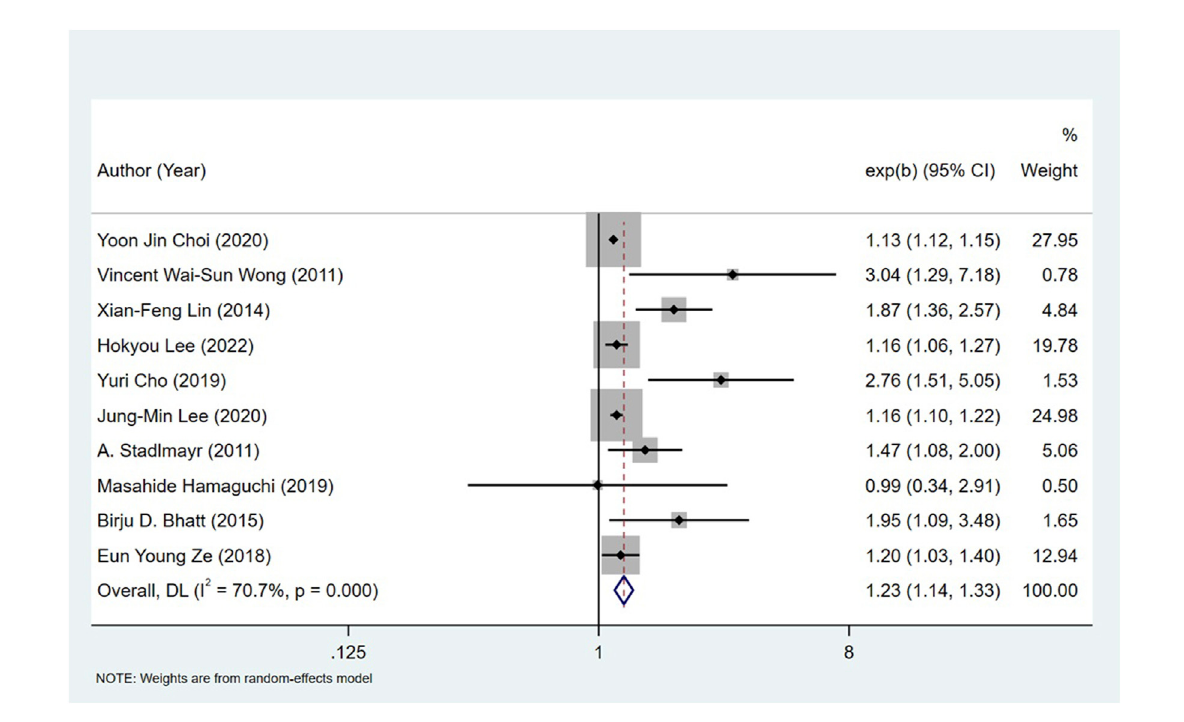
FIGURE 2 Forest plot showing the effect of NAFLD on CRC risk.